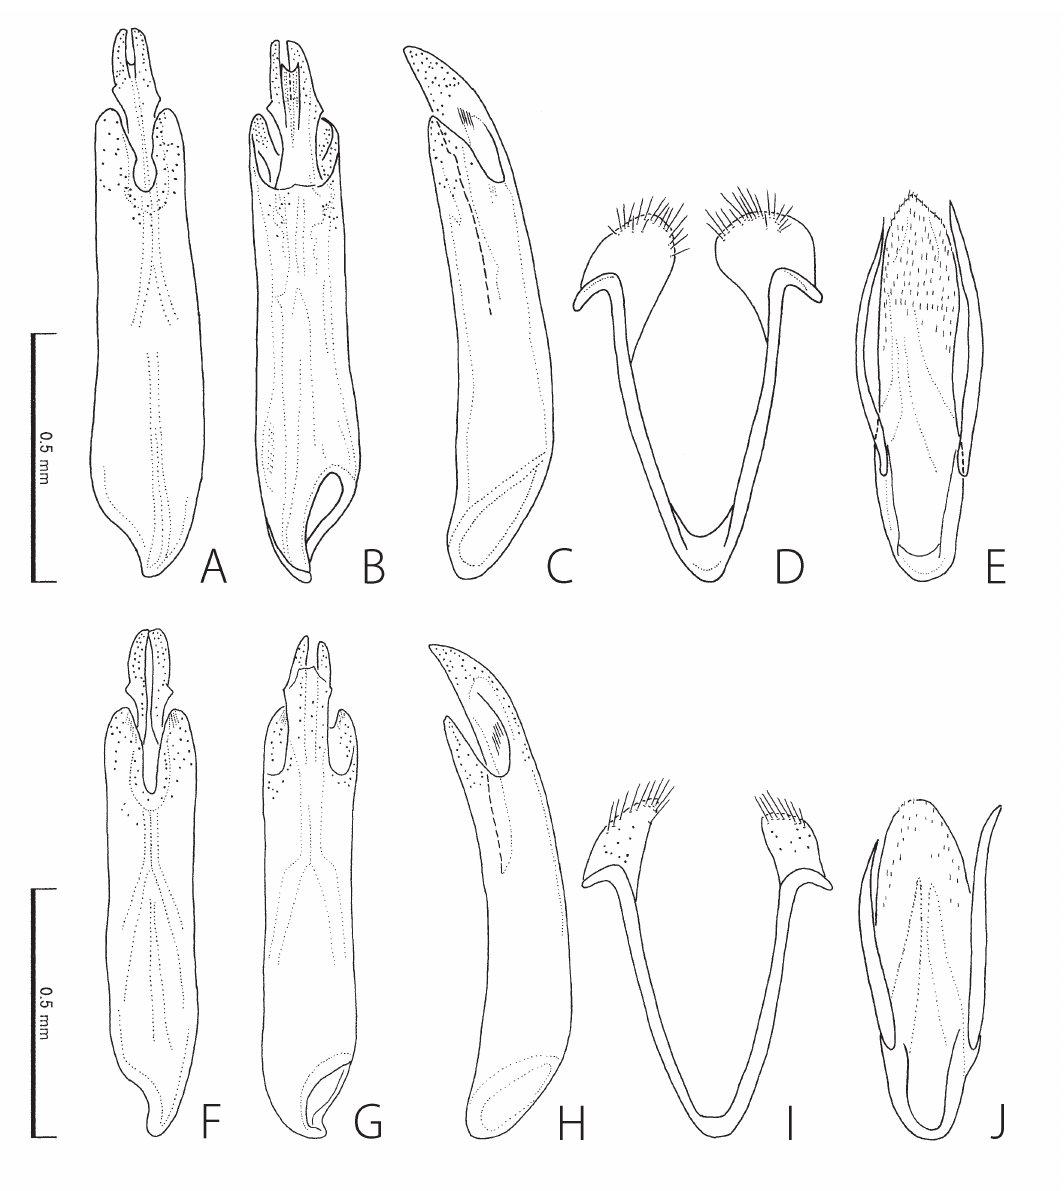
Fig. 2. Male genitalia of Caccothryptus spp. A–E . Caccothryptus taiwanus sp. nov. F–J . C . orion sp. nov. — A–C, F–H. Aedeagus in ventral (A, F), dorsal (B, G) and lateral (C, H) views. D , I . Sternite VIII. E , J . Sternite